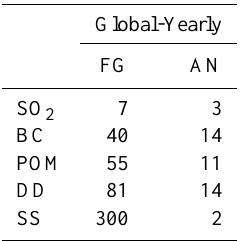
Table 5. Global-yearly emission errors with temporal dependence in % for the FG and the